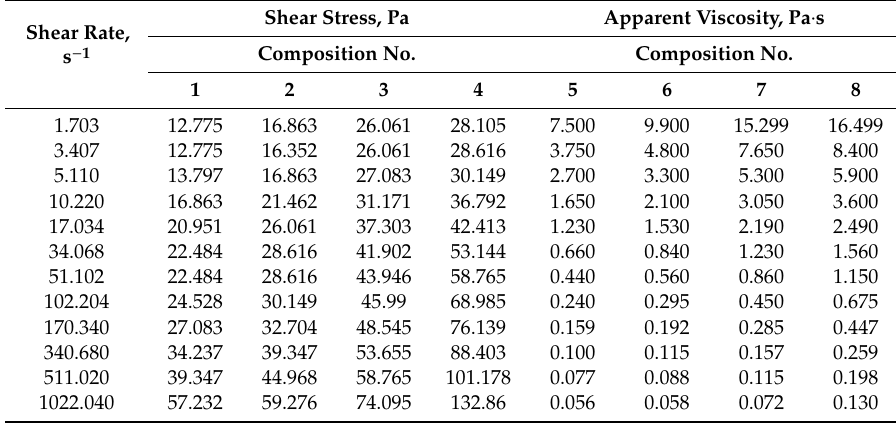
Table 5. Results of measurements and calculated values of apparent viscosity for slurries with graphene oxide containing a latex